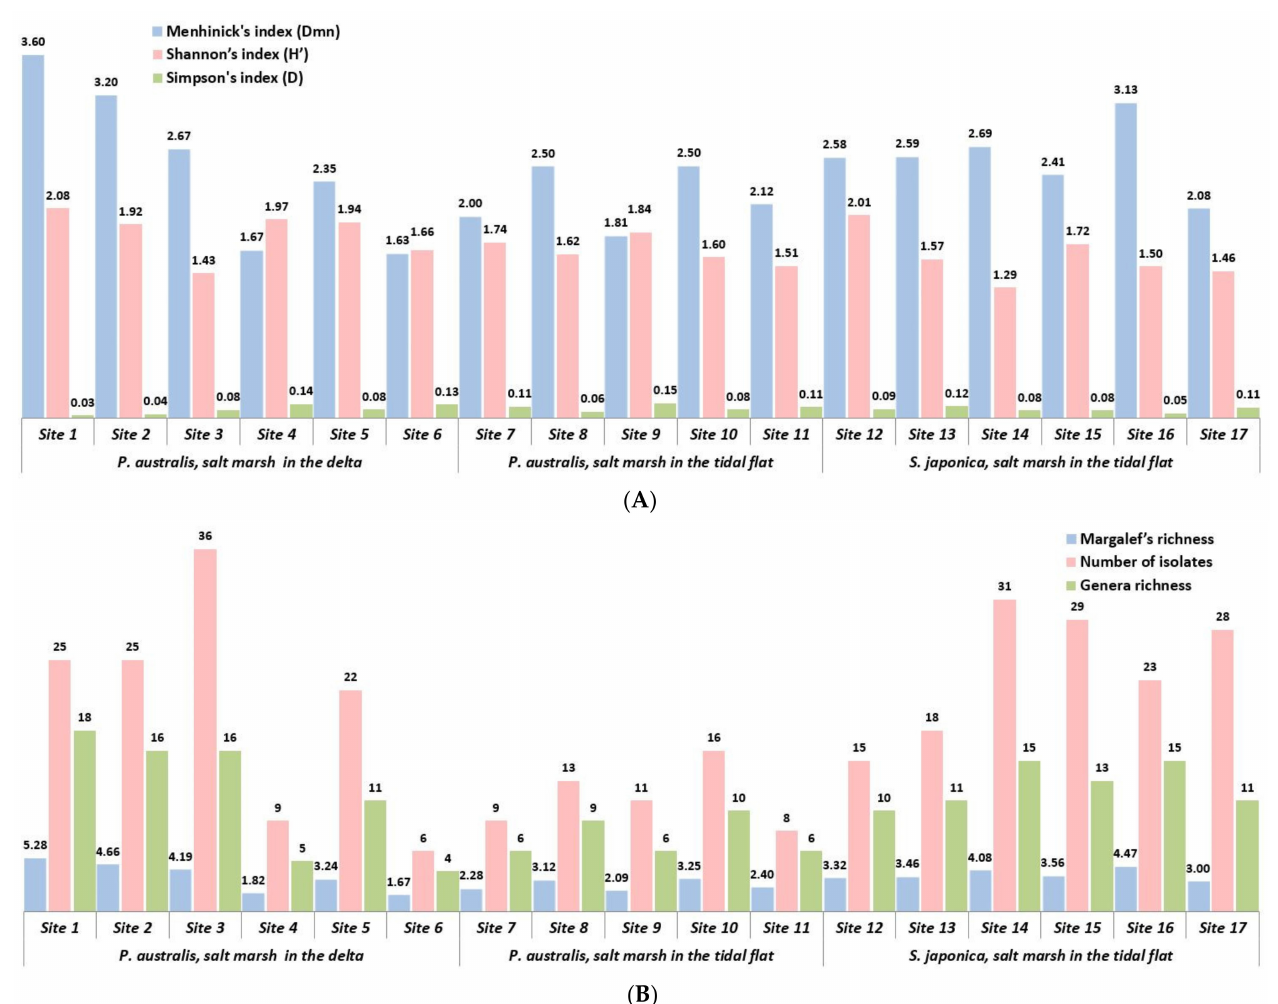
Figure 3. ( A ) Variation of Menhinick’s, Shannon’s, and Simpson’s indices at each sampling site. ( B ) Variation of morpholog- ical diversity and richness (genera and Margalef’s index) at each sampling